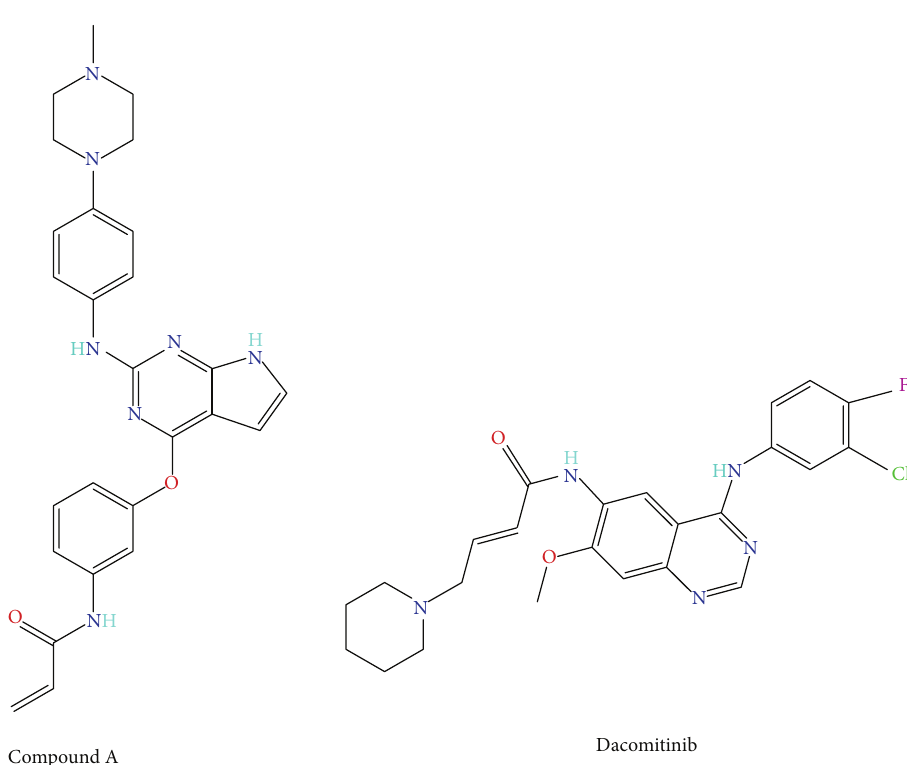
Figure 1: Structures of compound A and dacomitinib, irreversible inhibitors of mutant EGFR. These compounds were dosed in PC-9 cells to test the effects of EGFR irreversible inhibitors on turnover rate of mutant